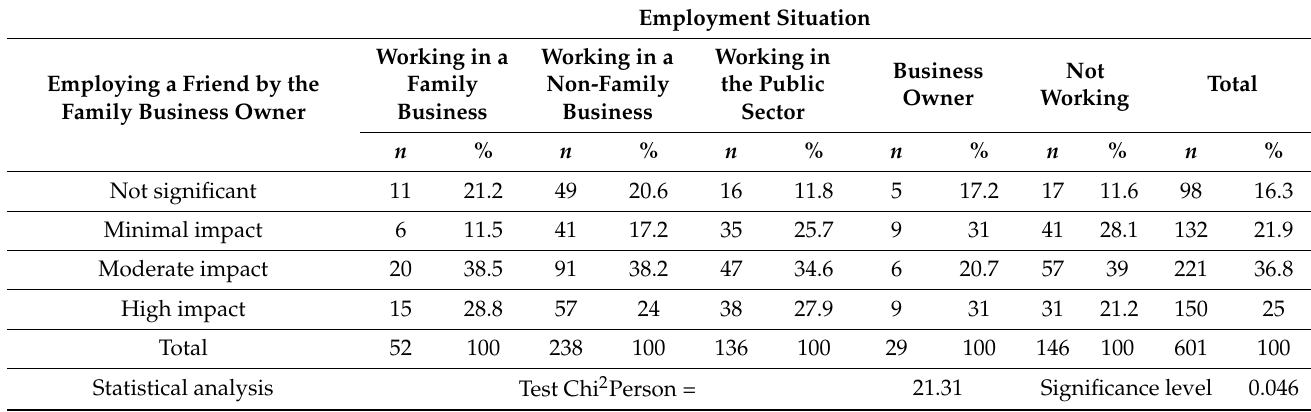
Table 9. Statistical analysis of the assessment of the impact of the Covid pandemic on employing a friend by the owner of the family business depending on the workplace.